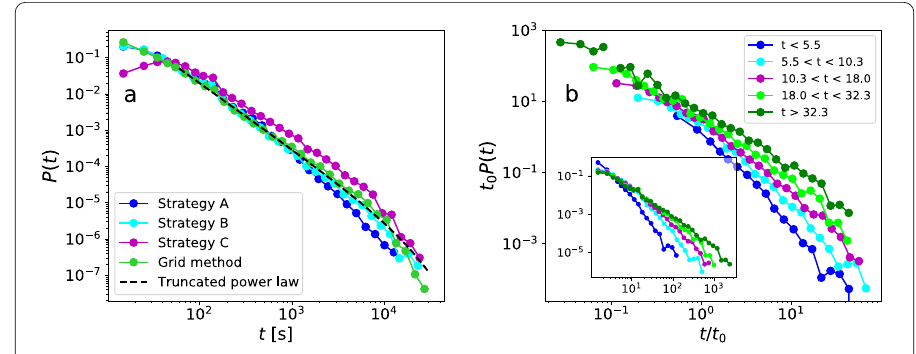
Figure 12 ( a ) Probability distributions of the waiting times resulting from the 3 interpolation strategies, together with the distribution of waiting times measured using the grid method. ( b ) Rescaled probability distributions of the waiting times measured over groups with different average waiting time t 0 . Inset: waiting time distributions measured over groups, before rescaling